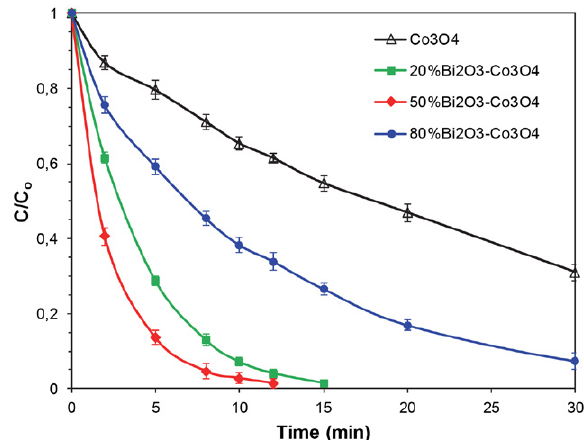
Fig. 6. AO7 catalytic degradation in x-Bi 2 O 3 -Co 3 O 4 composite/ PMS systems. Reaction conditions: [AO7] o = 50 mg/L; [PMS]/ [AO7] = 6; [Catalyst]= 0.1 g/L; initial pH = 3.04; T = 293 K.